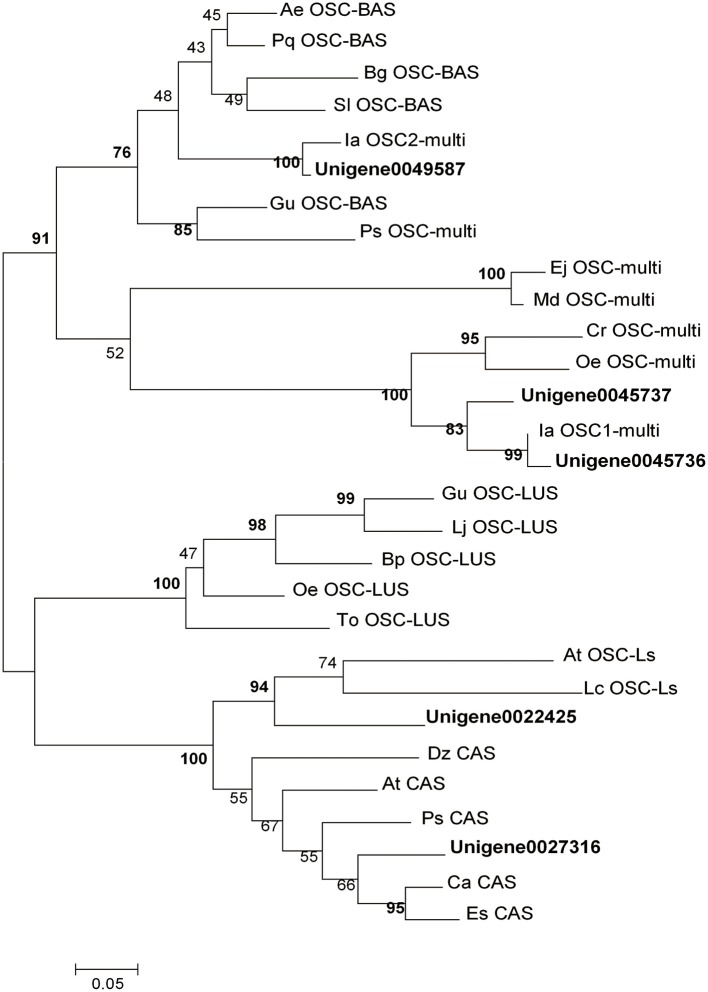
Phylogenetic analysis of OSCs. The statistical methods of this unrooted tree was maximum likehood method, which was tested by bootstrap method and the number of bootstrap replications was 1,000. The bold indicate the OSCs were selected from I. pubescens transcriptome and the others were randomly selected from GenBank. Ae, Aralia elata; At, Arabidopsis thaliana; Bp, Betula platyphylla; Ca, Cicer arietinum; Cr, Catharanthus roseus; Dz, Dioscorea zingiberensis; Ej, Eriobotrya japonica; Es, Eleutherococcus senticosus; Gu, Glycyrrhiza uralensis; Ia, Ilex asprella; Lc, Luffa cylindrica; Lj, Lotus japonicus; Md, Malus domestica; Oe, Olea europaea; Pq, Panax quinquefolius; Ps, Pisum sativum; Sl, Solanum lycopersicum; To, Taraxacum officinale. BAS, β-amyrin Synthase; CAS, cycloartenol synthase; LUS, lupeol synthase; LS, lanosterol synthase; Multi, multifunctional OSC gene.